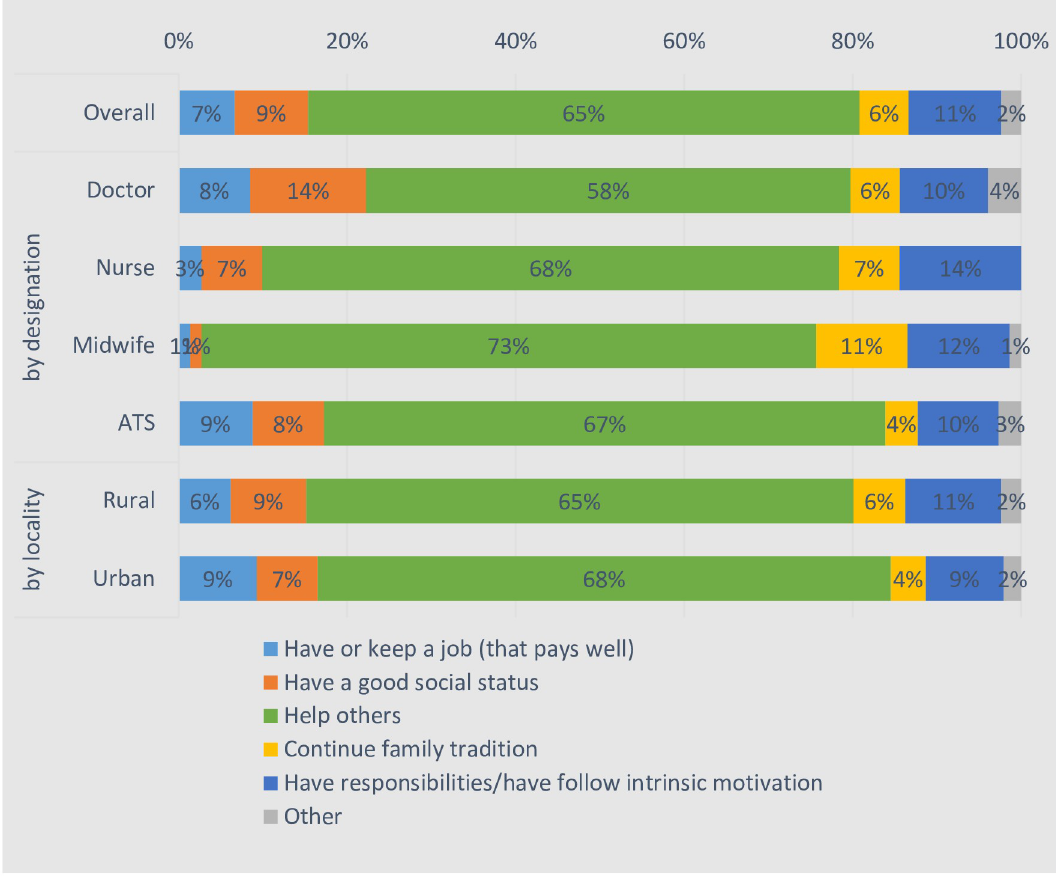
Fig 2. What was the main reason for you to become a health